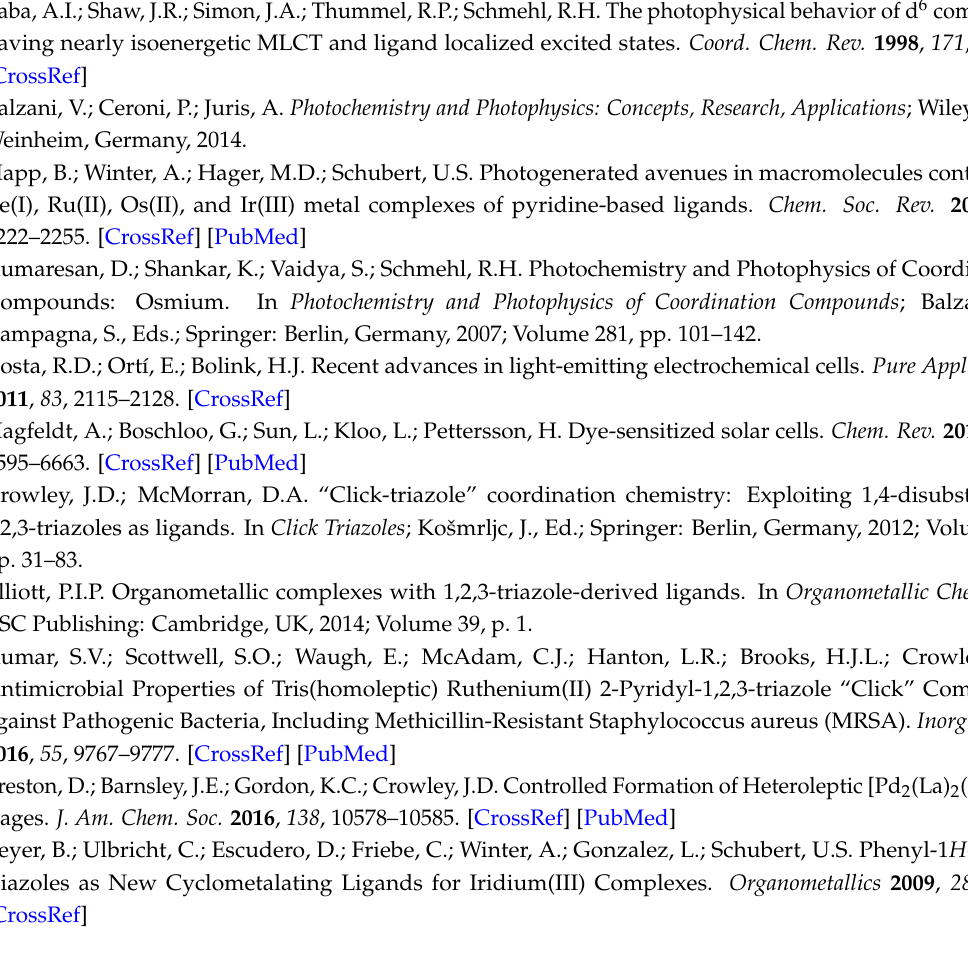
Figure S1: 1 H-NMR spectrum of 1 (CD 3 CN), Figure S2: 13 C-NMR spectrum of 1 (CD 3 CN), Figure S3: ESI mass spectrum of 1 , Figure S4: 1 H-NMR spectrum of 1 Cl ( d 6 -DMSO), Figure S5: 13 C-NMR spectrum of 1 Cl ( d 6 -DMSO), Figure S6: ESI mass spectrum of 1 Cl , XYZ coordinates for the optimized geometries of the ground and lowest lying triplet states of 1 , Figure S7: Time-dependent DFT UV-visible absorption spectrum of 1 , Table S1: Summarised time-dependent DFT data for 1